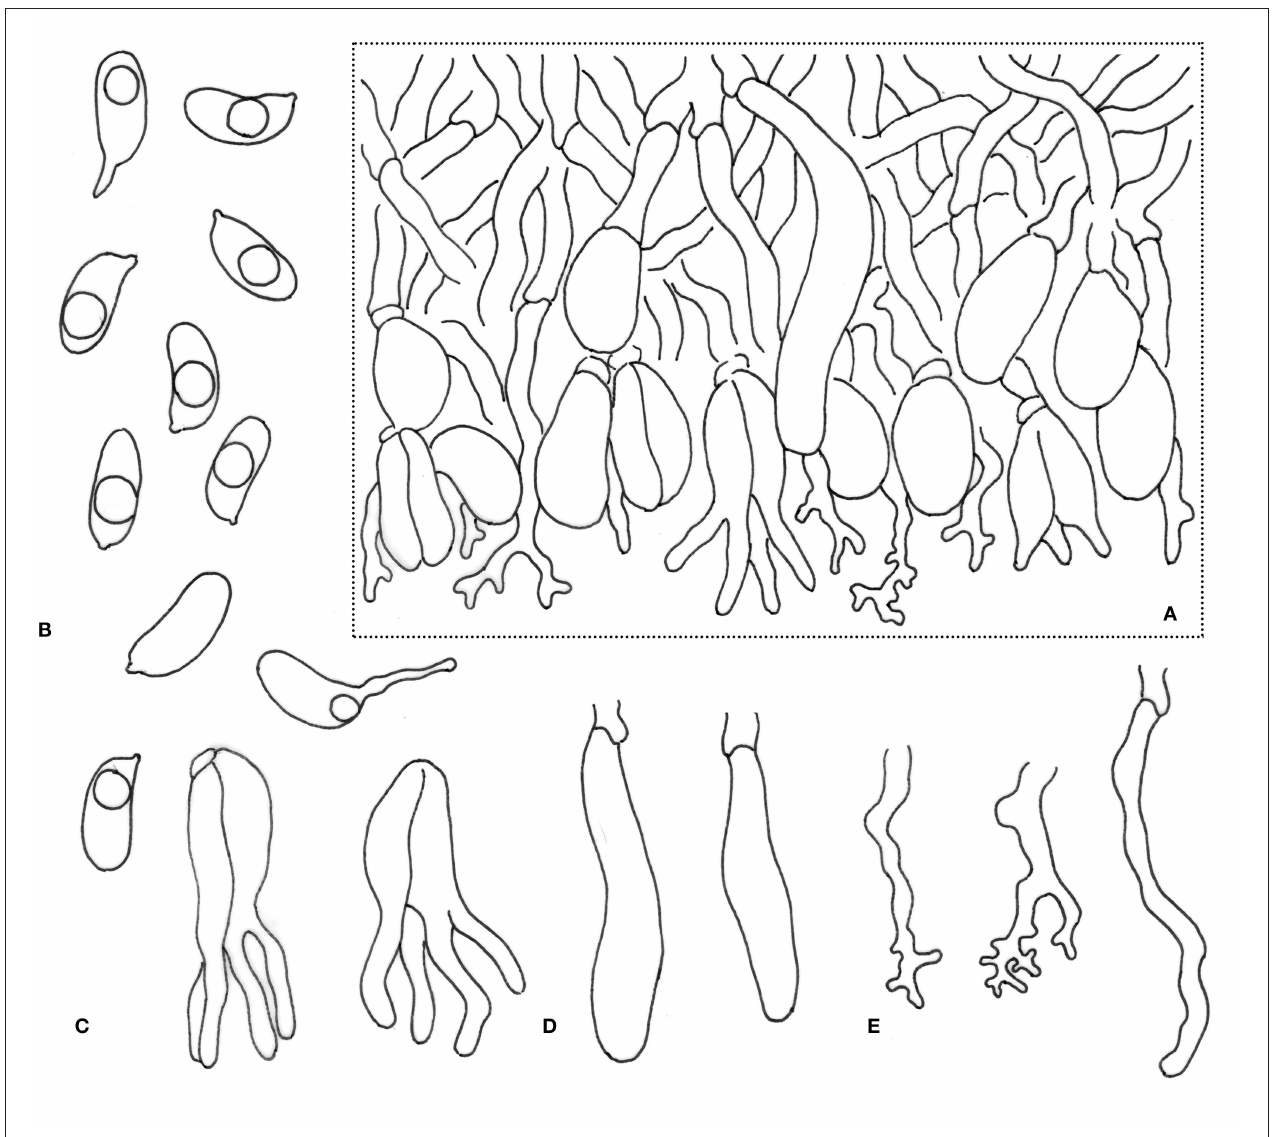
FIGURE 4 | Microscopic structures of Alloexidiopsis schistacea (drawn from the holotype). (A) A section of hymenium. (B) Basidiospores. (C) Basidia. (D) Cystidia. (E) Hyphidia. Scale bars = 10 µ m.